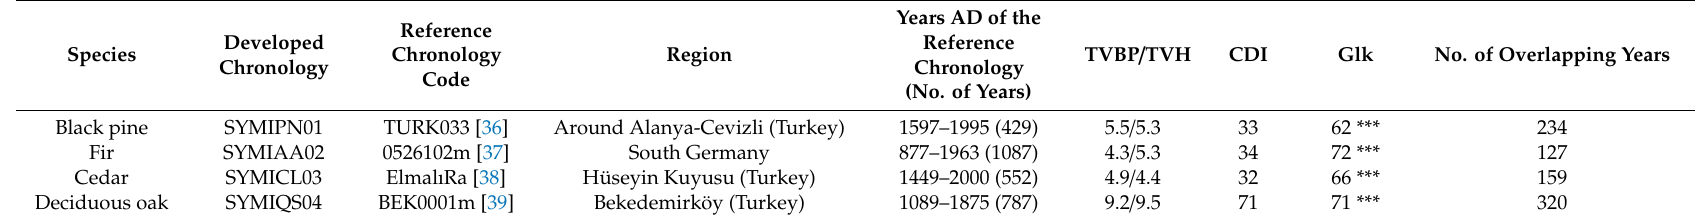
Table 3. Cross-dating results of the developed chronologies against the reference chronologies providing the best results. t-value Baillie-Pilcher (TVBP) and t-value Hollstein (TVH) are t -values sensitive to extreme values, such as marker years. CDI = Cross-Dating Index; Glk = Gleichlaeufigkeit, a measure of how well the growth of two trees corresponds to each other in an overlapping set of